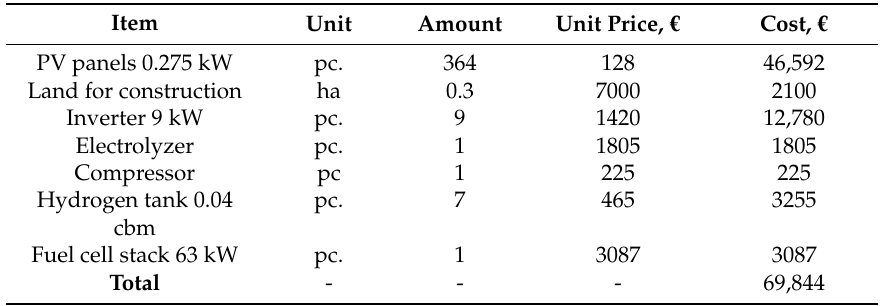
PV panels 0.275 kW